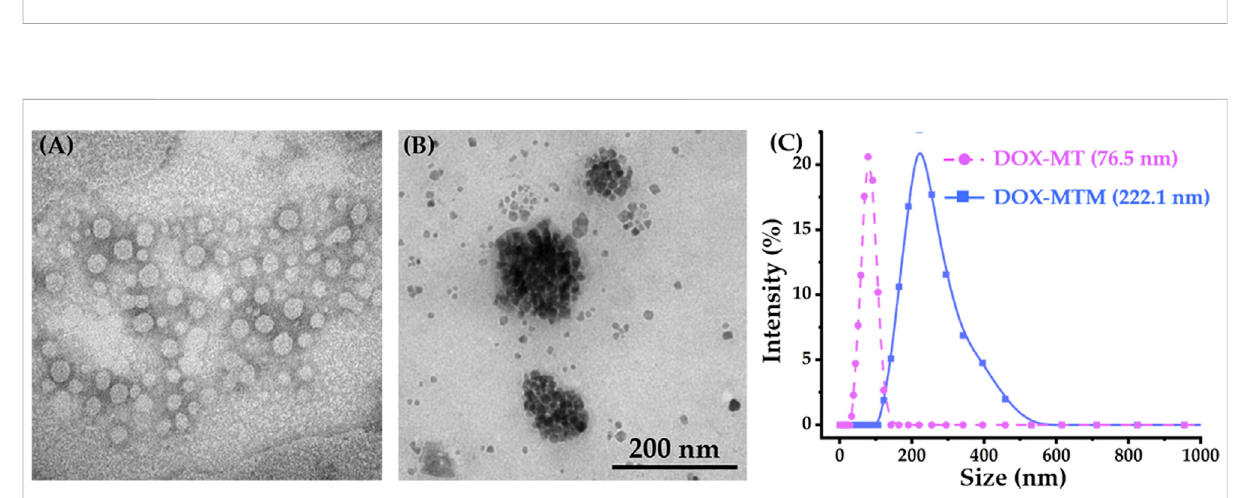
FIGURE 3 Structure characteristics ofPCL- b -poly(N- co -D) – Cy7: (A) 1 H NMR spectrum of PCL- b -poly(N- co -D)-Cy7, marking all characteristic peaks; (B) UV – Vis spectra of PCL- b -p(N- co -D), Cy7, and PCL- b -p(N- co -D) – Cy7.